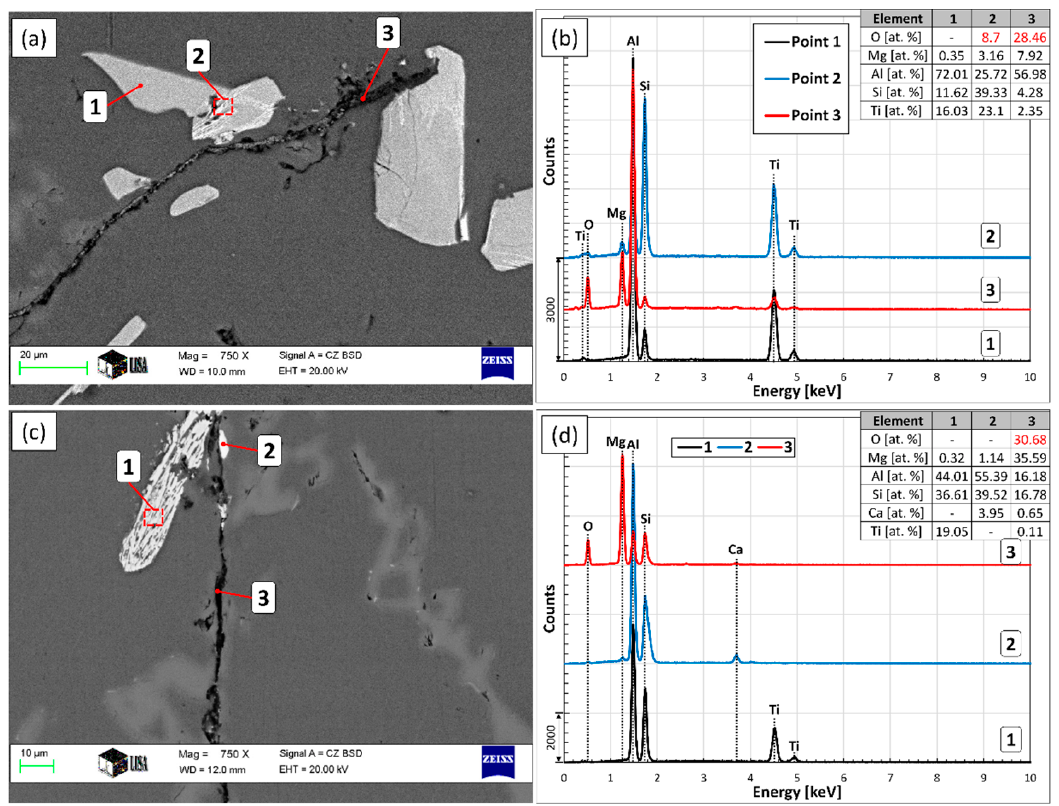
Figure 12. ( a , c ) SEM images of bifilms (point 3 in both images) and intermetallic particles (points 1 and 2), ( b , d ) results of the EDS analysis at the indicated points.